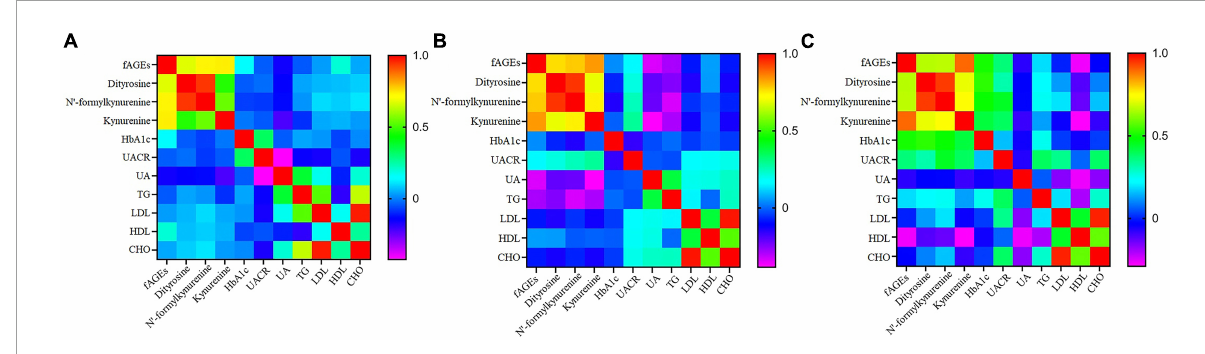
FIGURE3 The heatmap of correlation coefficient of fluorescent advanced glycation end products (fAGEs), dityrosine, N’-formylkynurenine and kynurenine, HbA1c, UACR, UA, TG, LDL, HDL, and CHO in patients with diabetes duration ≤ 5 years (A) , 5–10 years (B) , and ≥ 10 years (C) .